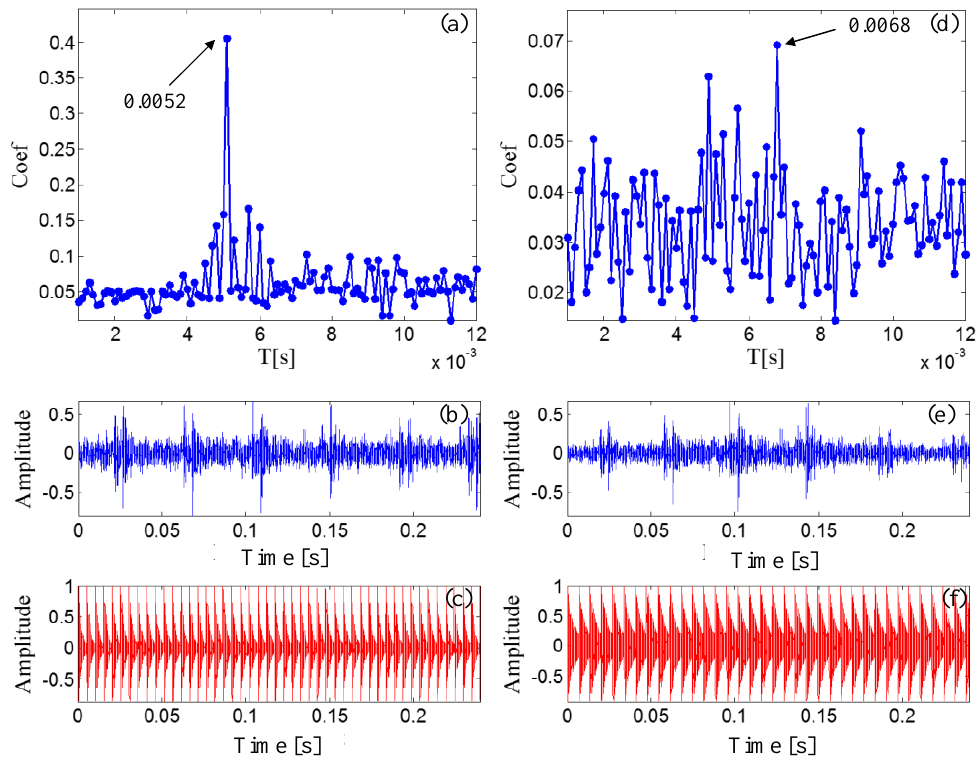
Figure 24. Results for Doppler-shifted bearing signal with the inner-race defect using the transient model analysis method ( a ) maximal correlation coefficients for different elements from set T after Doppler effect elimination; ( b ) wave form of the Doppler-free signal; ( c ) the optimal periodical transient model for the Doppler-free signal; ( d ) maximal correlation coefficients for different elements from set T before Doppler effect elimination; ( e ) wave form of the Doppler-shifted signal; ( f ) the optimal periodical transient model for the Doppler-shifted